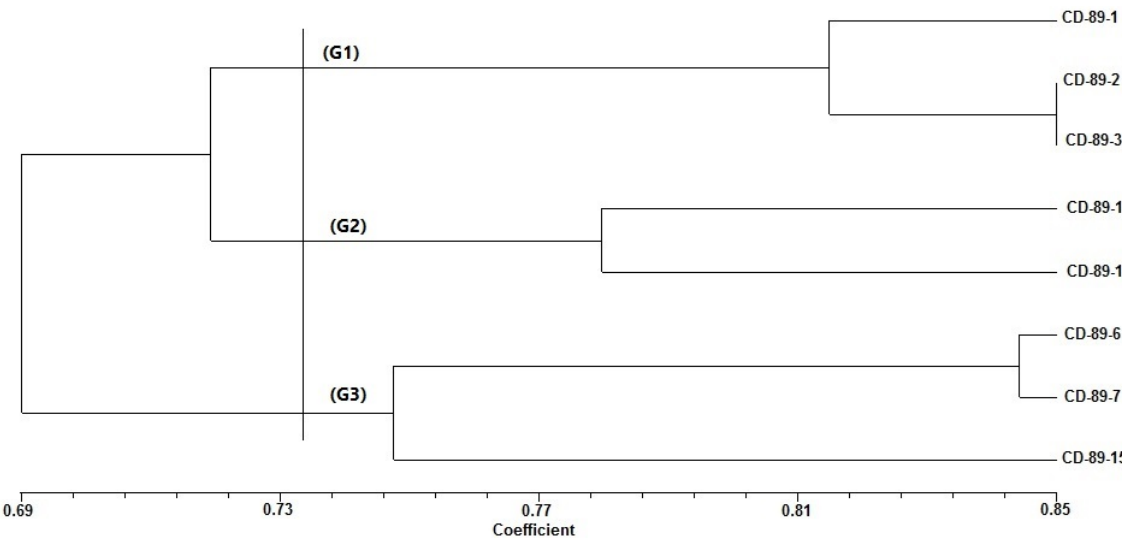
Fig. 1. UPGMA dendrogram showing the relationships among eight wheat genotypes. Table 6 . Nei's genetic distance and similarity matrix for three wheat groups. Nei ՚ s genetic distance matrix Nei ՚ s genetic similarity matrix Genotypes